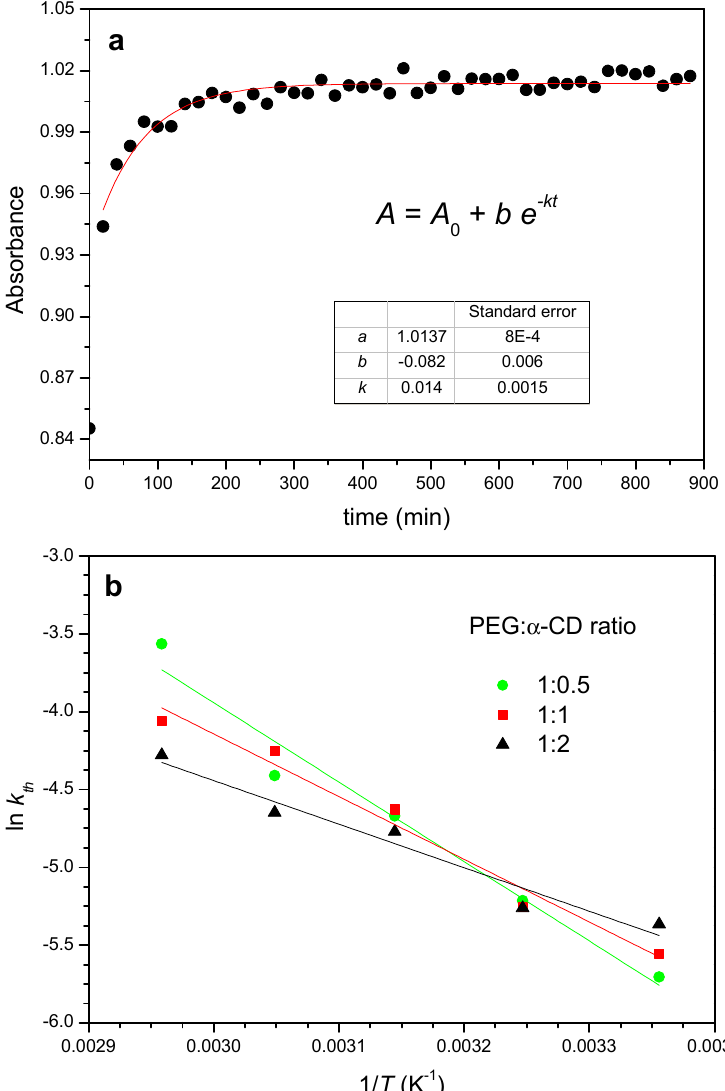
Figure 2. ( a ) Kinetic profile obtained from FTIR data for the reaction between PEG400 and α -CD (1:1 feed ratio) at 55 °C and corresponding fit. ( b ) Arrhenius plots for the reaction at different feeds. Table 1. Rate constants obtained from FTIR for the reaction of PEG400 with α -CD at different feeds (PEG:CD) and